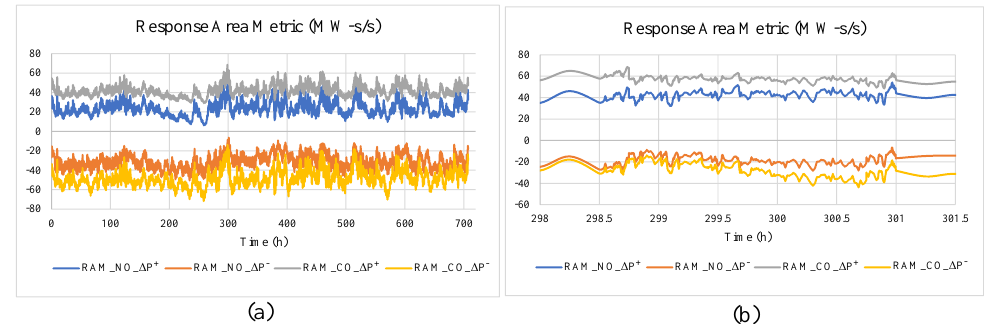
Figure 15. RAM evaluated in real time: ( a ) For full 720 h; ( b ) the zoomed section shows the dy- namic